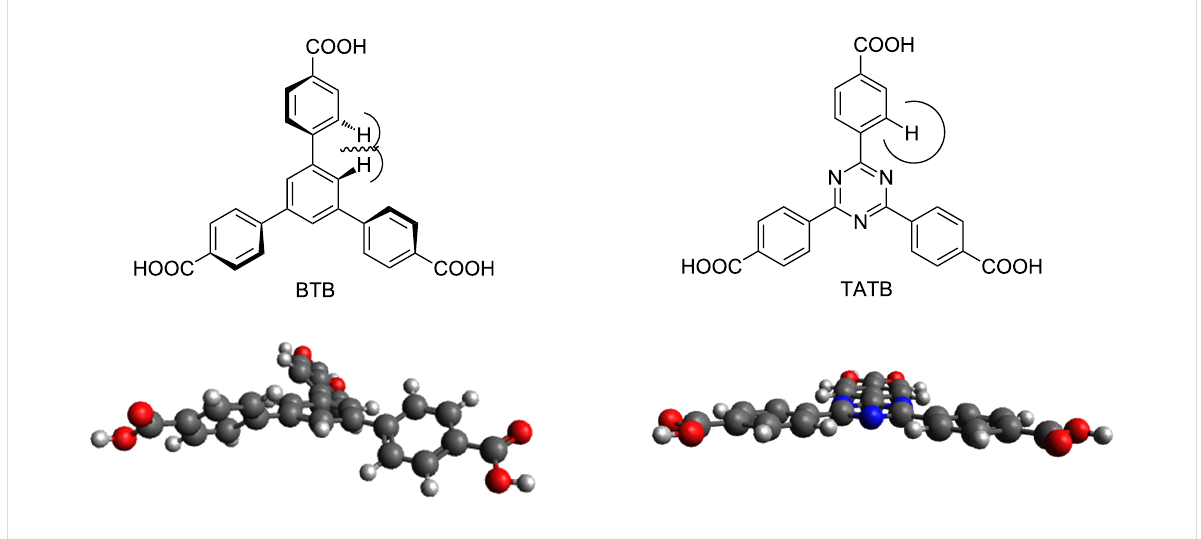
Figure 1: Steric repulsion between ortho -hydrogen atoms in benzene-1,3,5-tribenzoic acid (BTB) leads to a non-planar structure (left). The exchange of CH units by nitrogen atoms in the central six-membered ring allows a planar structure: 1,3,5-triazine-2,4,6-tribenzoic acid (TATB, right). The two structures in the lower half have been calculated with B3LYP//6-31G*.